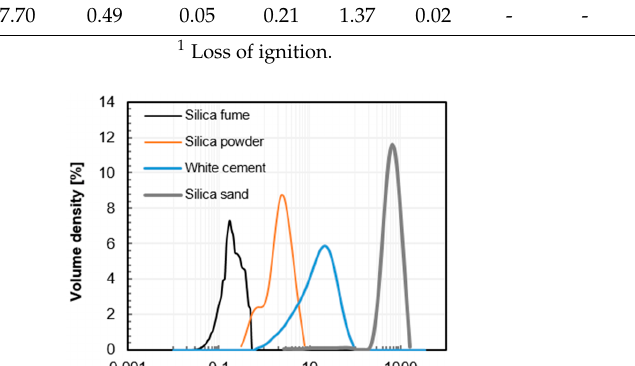
Table 2. Oxide compositions of raw materials used (wt %).